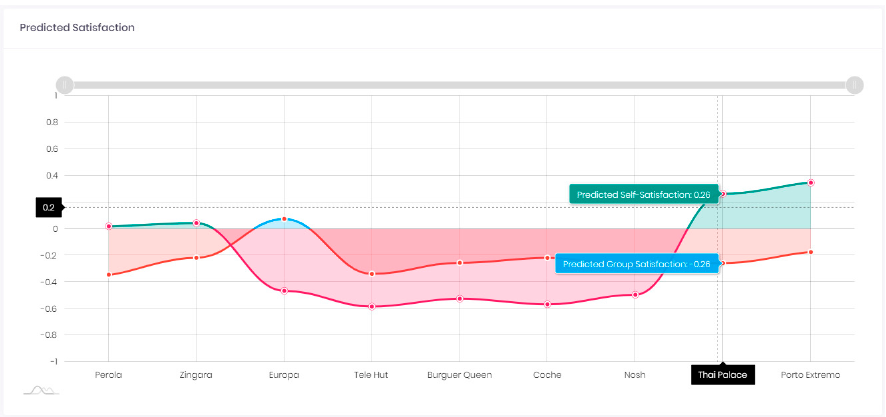
Figure 5. Graph of the “Personal Information” screen.